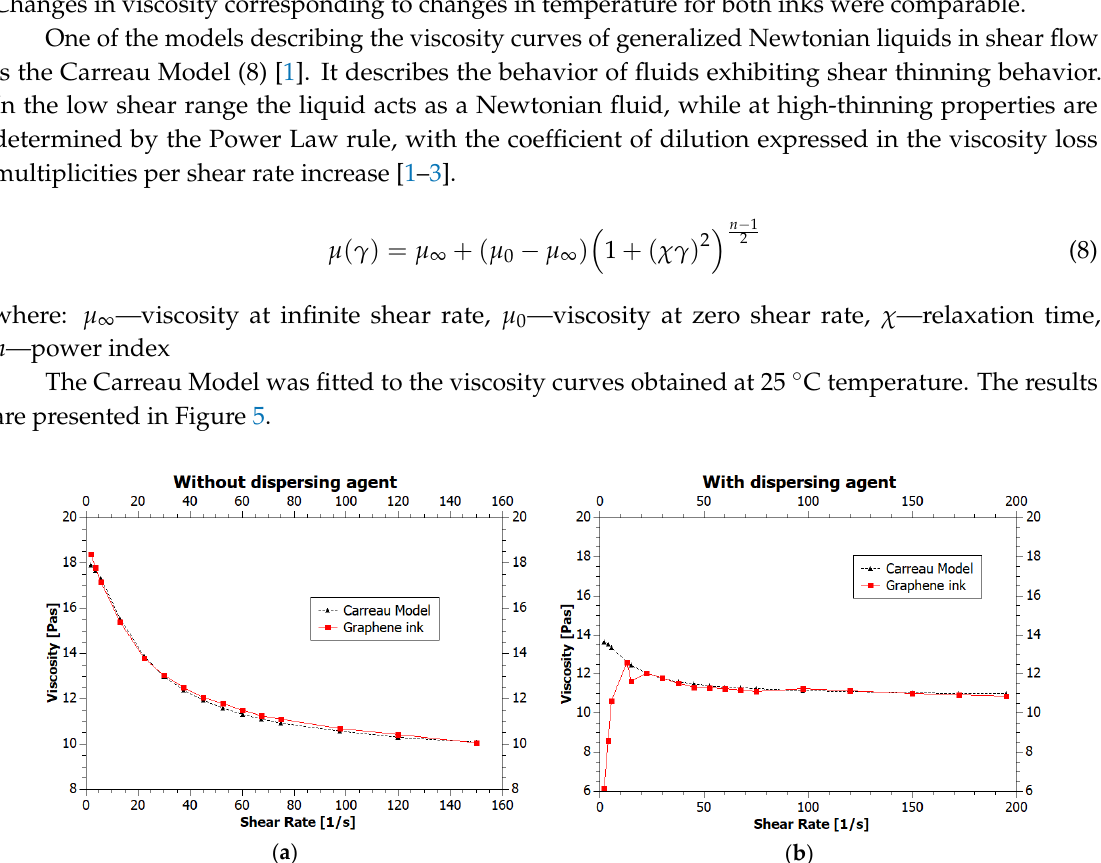
Table 1. The viscosity values of the graphene inks.